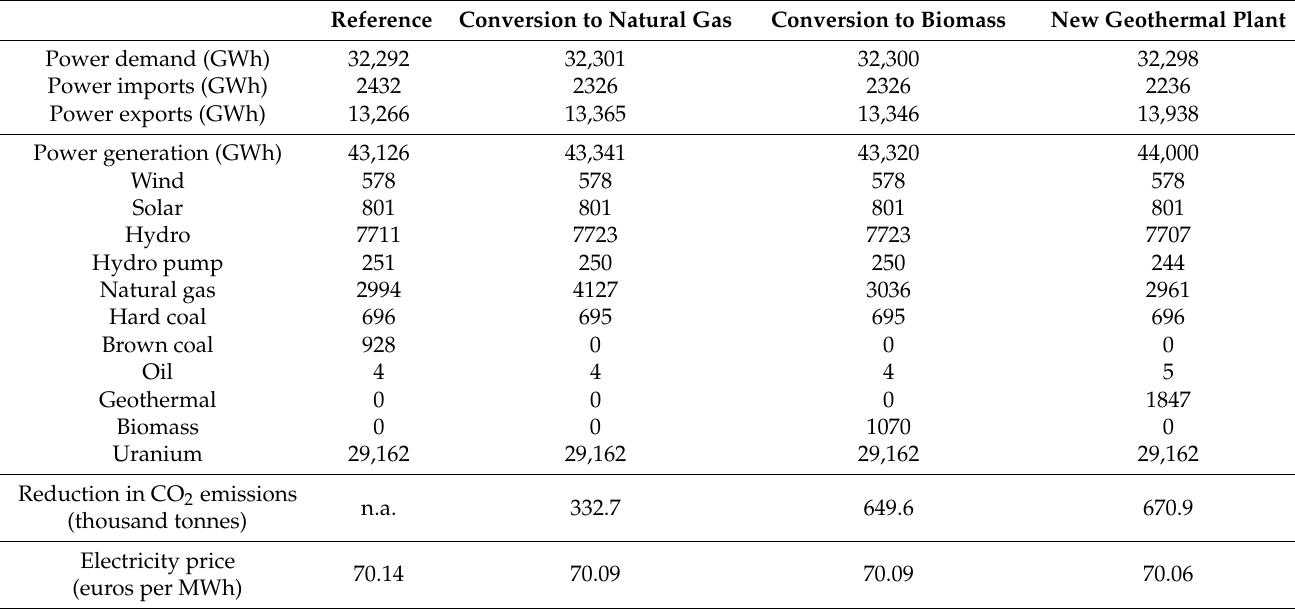
Table 2. Cross-border flows, generation mix, and electricity prices in Slovakia in 2030.